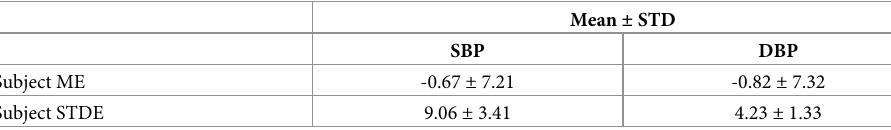
Table 5. Subject-wise BP estimation performance on the test set in